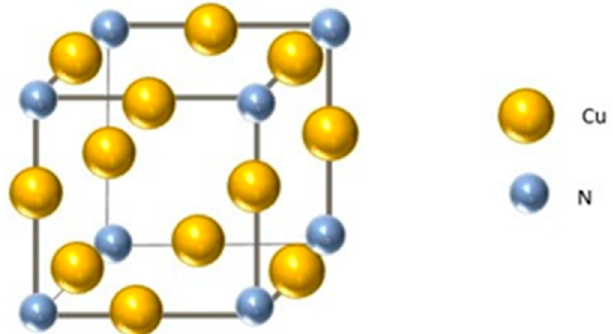
Figure 1. Picture of the anti-ReO 3 crystal structure of the Cu 3 N compound. The copper atoms are represented by the yellow balls, and the nitrogen by the grey balls.